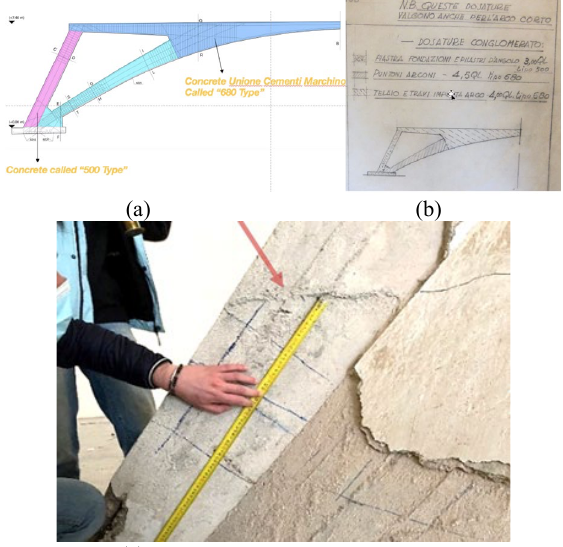
Figure 7 . The analysis focused on the basements elements of the inclined arches: (a) different pouring stages and (b) casting of different concrete typology in the Nervi’s design document; (c) cracks detected at the base of all arches.